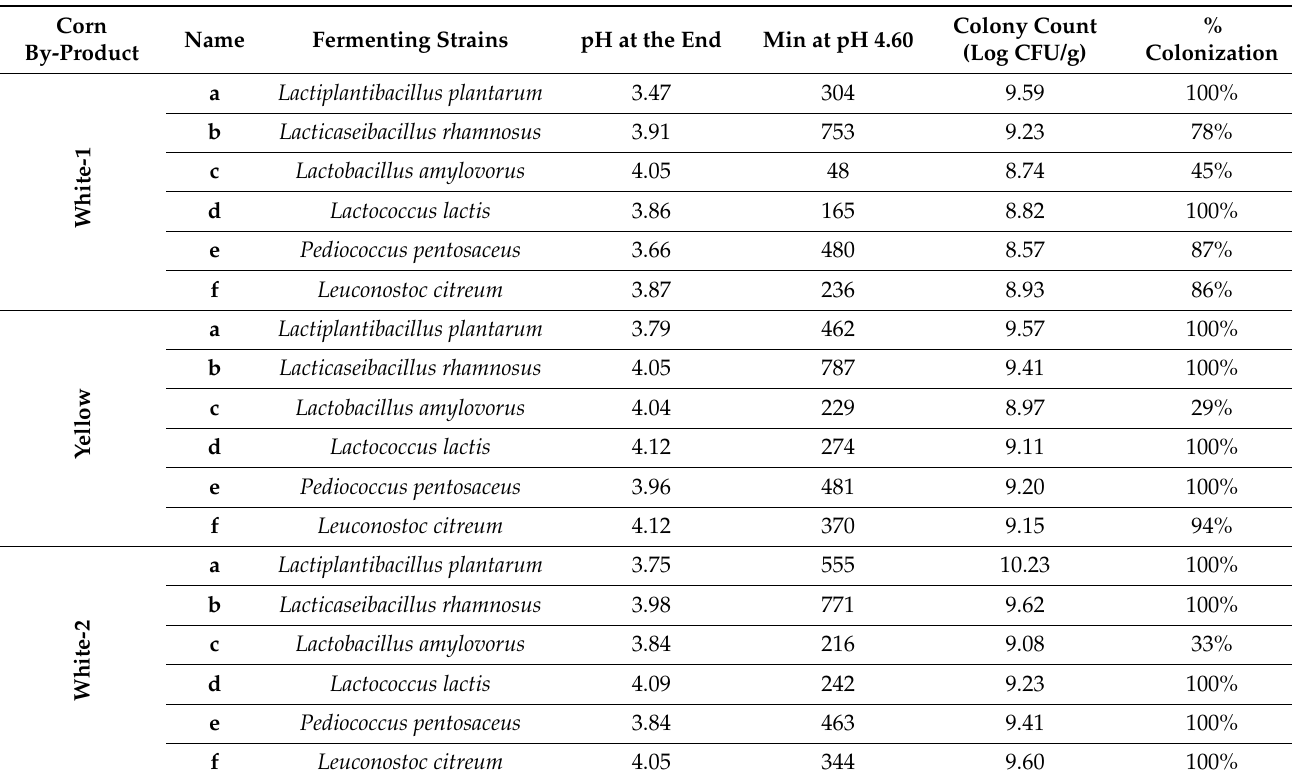
Table 2. Evaluation of corn by-product parameters after fermentation with different bacteria strains: pH values, colony count, and % of colonization were